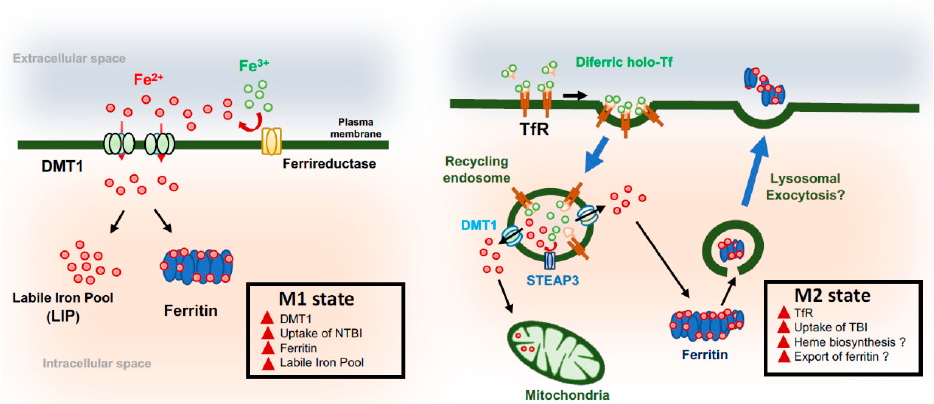
Figure 2. Iron trafficking and microglial cell polarization. ( Left ) Pro-inflammatory stimuli upregulate the expression of divalent metal transporter-1 (DMT-1) and the uptake of non-Tf-bound iron (NTBI).